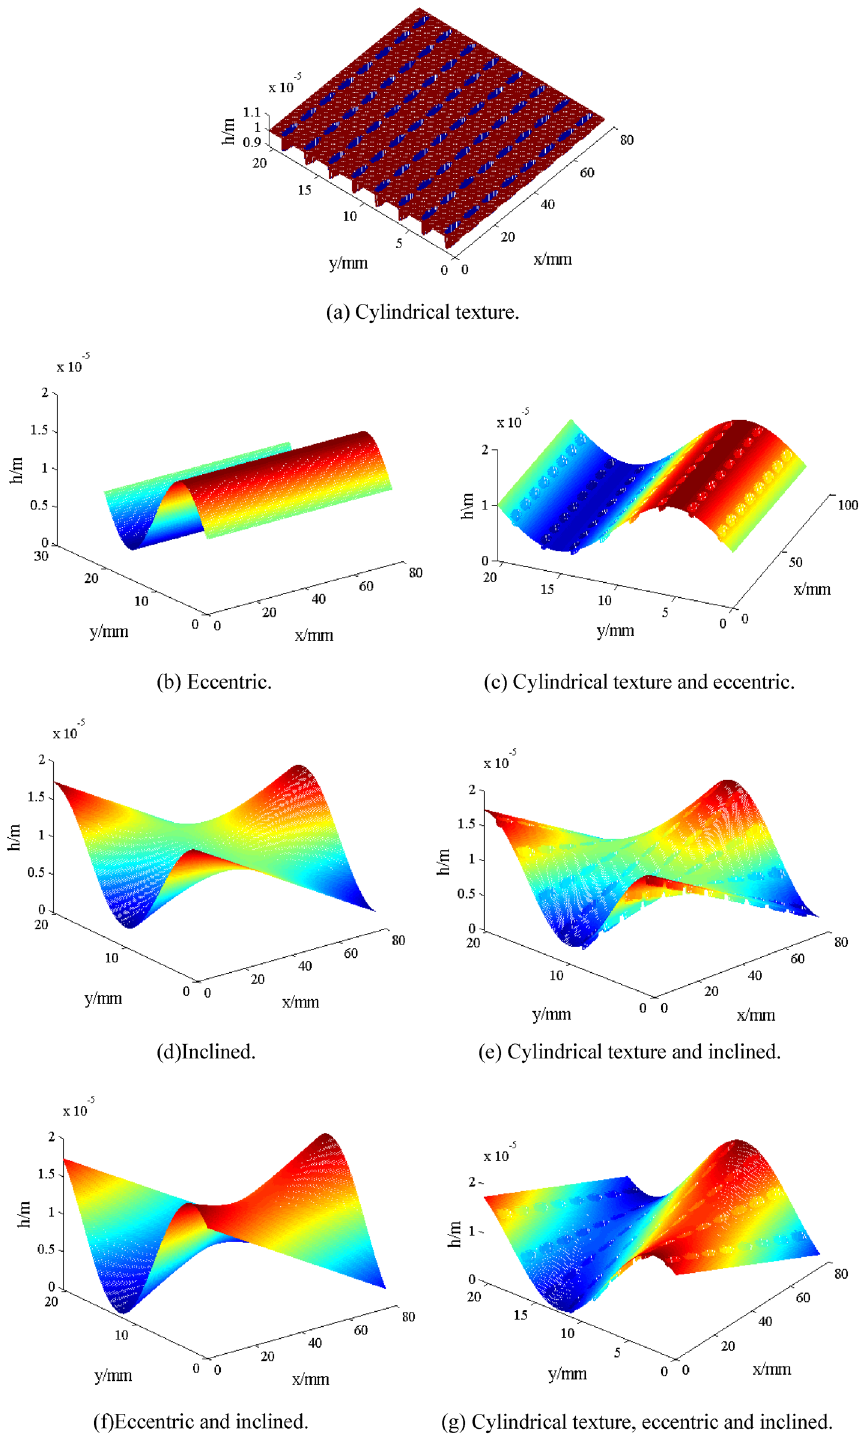
Figure 5. Distribution of oil film thickness on the outer surface of the piston under different